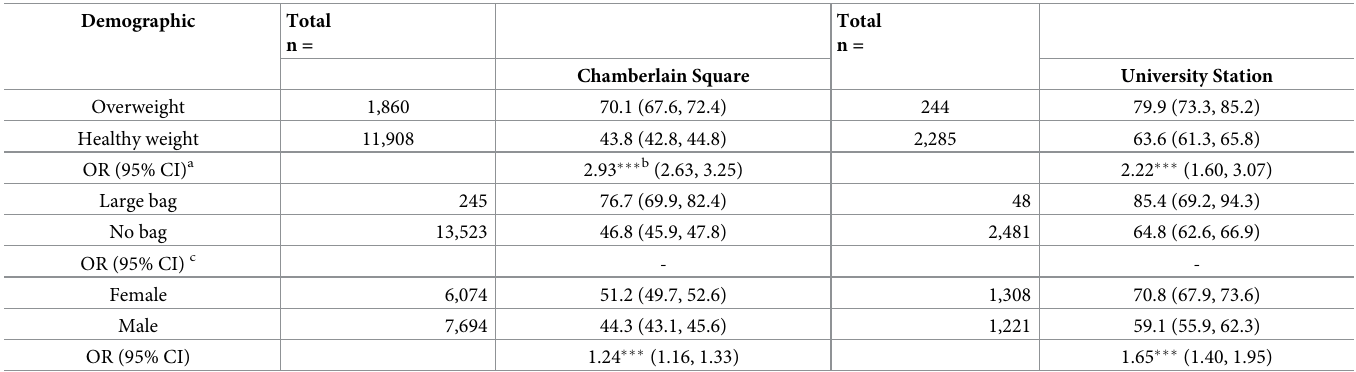
Table 5. Percentage avoidance of stairs (95% CI) by choosing slopes at Chamberlain Square and University station by demographic group. Demographic Total